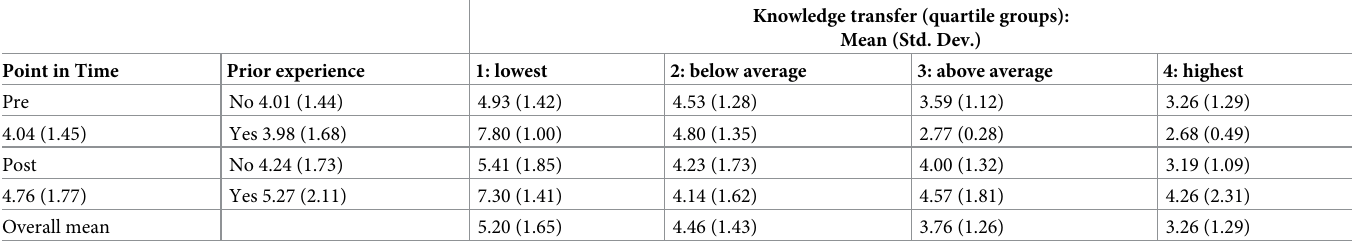
Knowledge transfer (quartile groups): Mean (Std. Dev.)